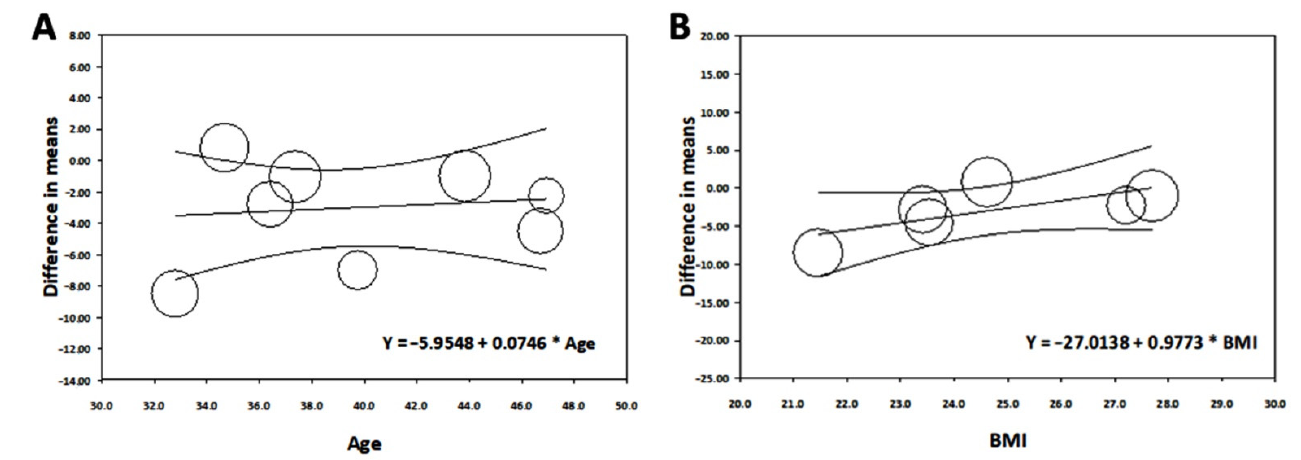
Figure 7. Meta-regression analysis performed for mean differences in serum vitamin D levels between shift and non-shift workers, with age ( A ) and BMI ( B ) as covariates.